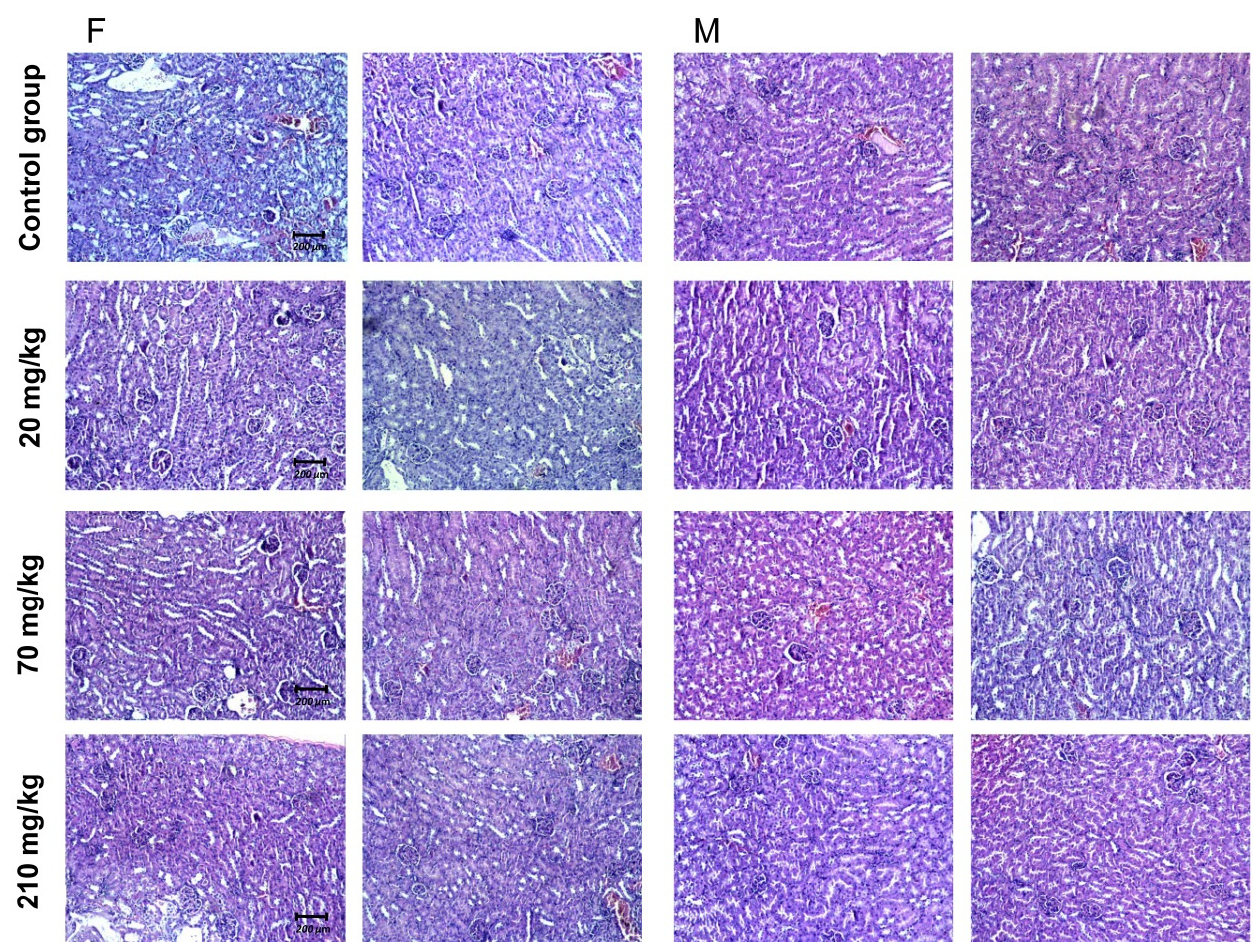
Figure 6. Pathomorphological findings of mice kidney tissue specimens after oral administration of G. urbanum EtOAc-AP extract for 14 days. The four groups of animals with preparations from two animals of each sex and group are presented in the picture. Three groups of each sex were administered with a different dose of the extract—20, 70 or 210 mg/kg. The control group received no extract. Legend: F—female animals; M—male animals; field magnification – 200x. Table 6. Histological findings in kidney tissue specimens of female and male mice with EtOAc-AP extract of G. urbanum administrated orally for 14 days.